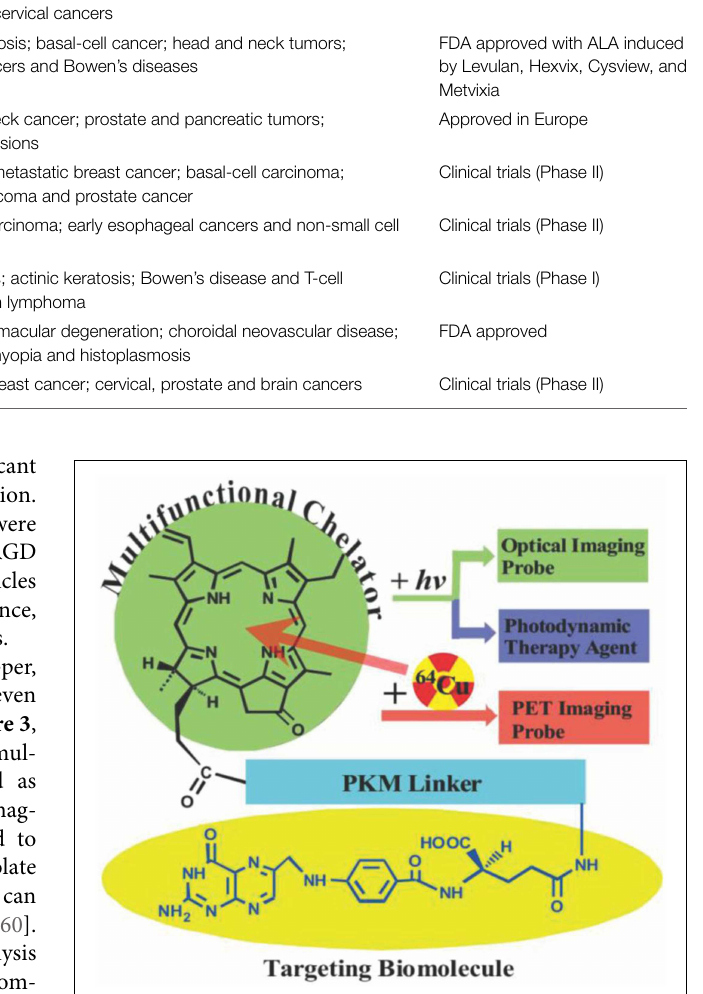
FIGURE 3 | Pyro-pharmacokinetic modifying linker (peptide sequence)-folate (PPF) structure design (Adapted with permission from Shi et al.